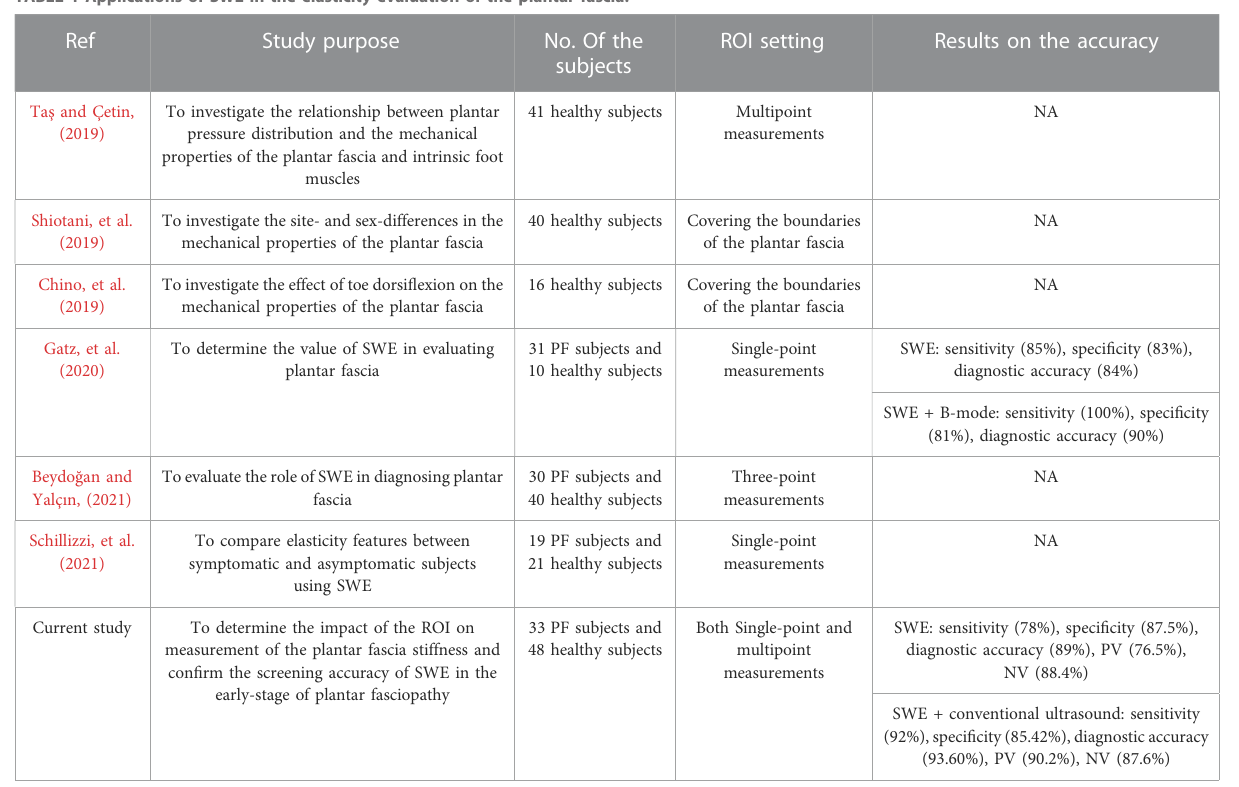
TABLE 1 Applications of SWE in the elasticity evaluation of the plantar